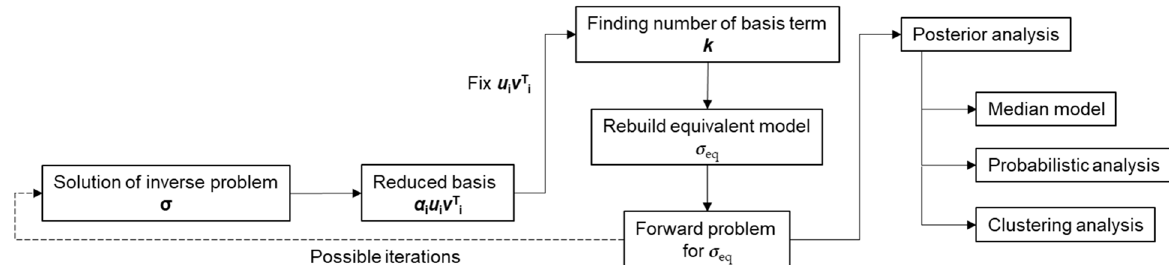
Figure 1. Flowchart of the method used here to perform the uncertainty analysis.